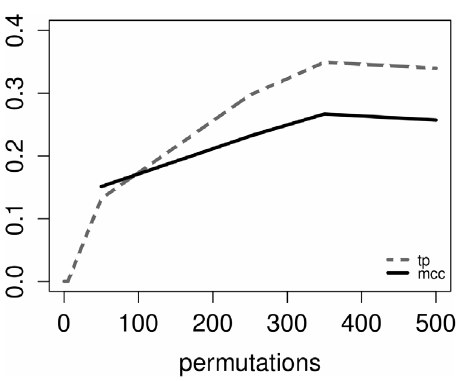
Figure 3. Number of predicted edges and false negatives vs. number of permutations.